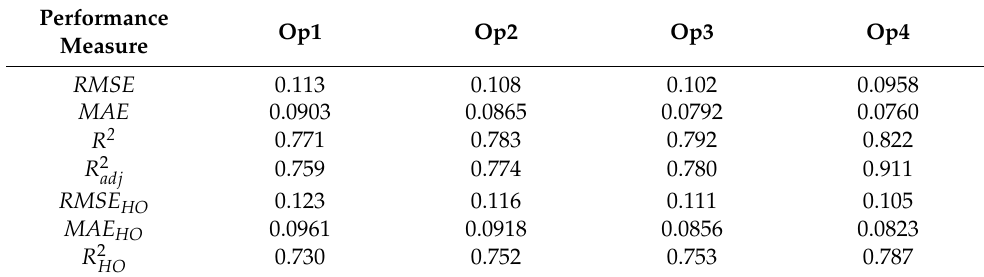
Table 3. Performance measures of the models developed under the four outlier detection options. Performance